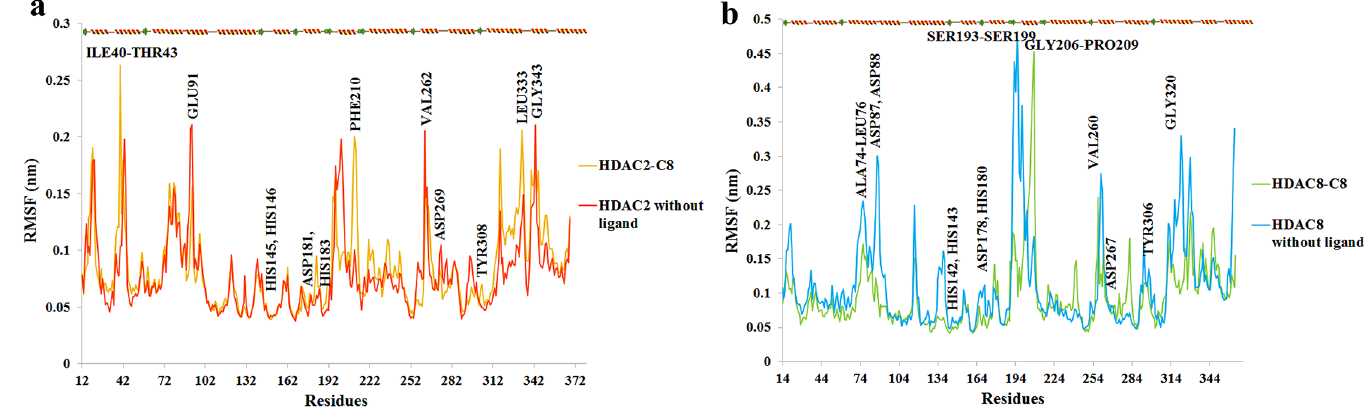
Fig 8. RMSF plot for 12 ns MD simulation. (a) RMSF plot for HDAC2-C8 complex (yellow) and HDAC2 without ligand (red). (b) RMSF plot for HDAC8-C8 complex (green) and HDAC8 without ligand